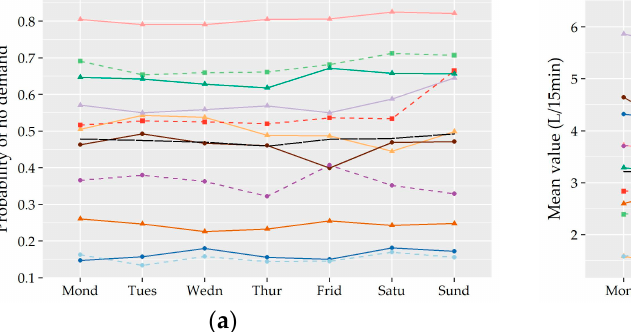
Figure A1. Box plots depicting the nonzero 15-min (left column) and hourly (right column) water demand records of House #4, on monthly ( a , b ); daily ( c , d ) and hourly basis ( e , f ).